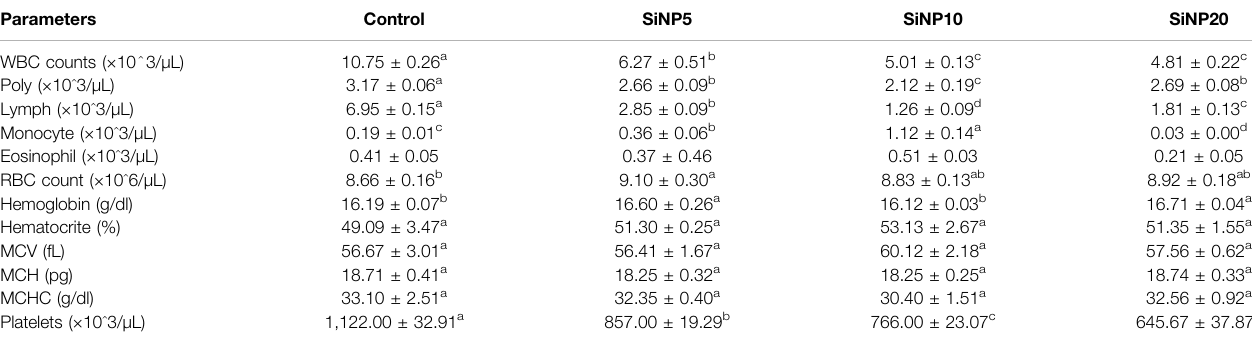
Data represent mean ± SD ( n = 3). Different letters in the same row indicate signi fi cant difference ( p > 0.05). Values represent mean ( n = 3) ± SD.